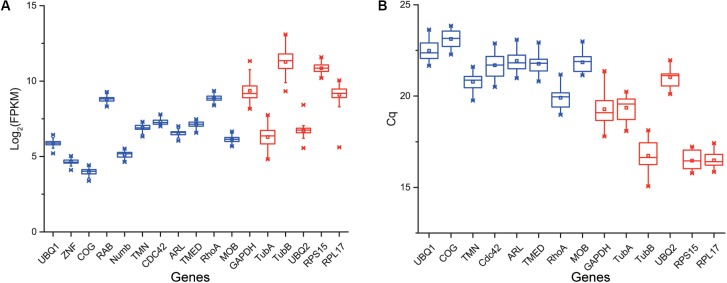
Boxplot showing the distribution of expression level (FPKM) of 11 novel candidate reference genes (blue) and six commonly used reference genes (red) based on RNA-Seq data (n = 45) (A), and the distribution of expression level (Cq) of eight novel candidate reference genes (blue) and six commonly used reference genes (red) based on RT-qPCR (B). Whisker caps represent maximum and minimum values, the upper and lower lines of the box represent the 25/75 percentiles, the line across the box represents the median, and the asterisk indicates outliers.